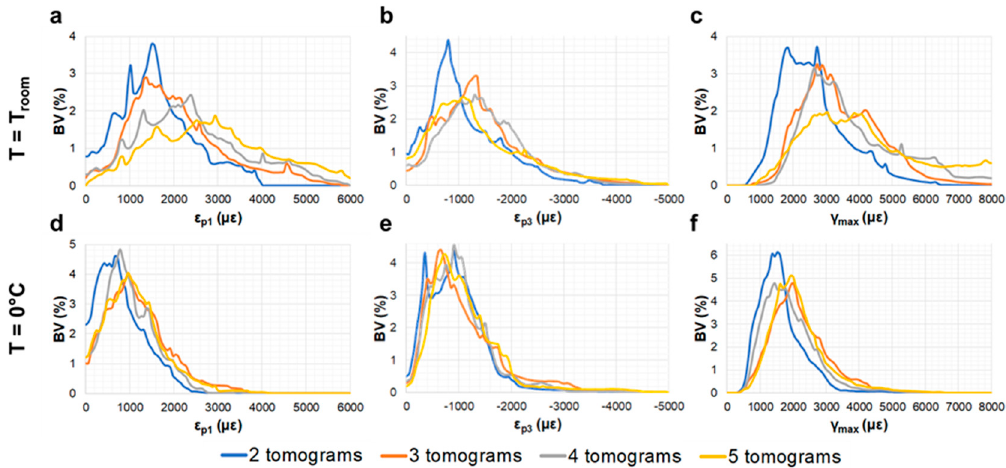
Figure 5. Histograms of the residual strain distribution in trabecular bone tissue imaged at room temperature (top) and 0 °C (bottom). ( a , d ) First principal strains ( ε p1 ), ( b , e ) third principal strains ( ε p3 ) and ( c , f ) maximum shear strains ( γ max ) after each acquired tomogram are shown.